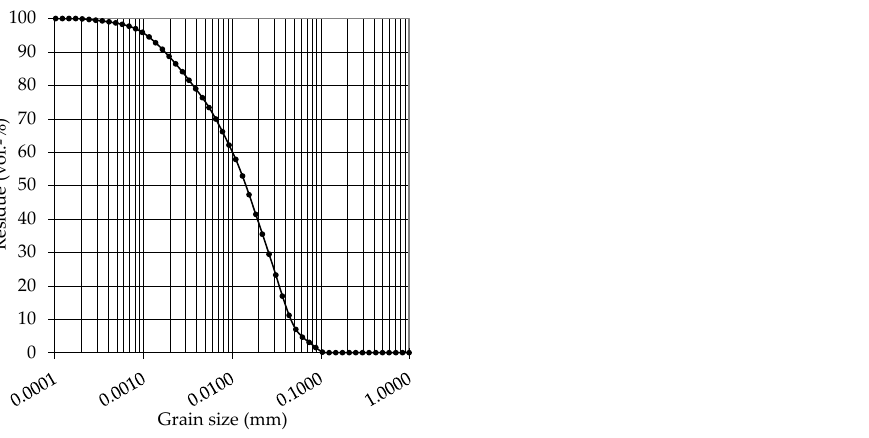
Figure 5. Grain size distribution of the used Ordinary Portland cement (OPC).